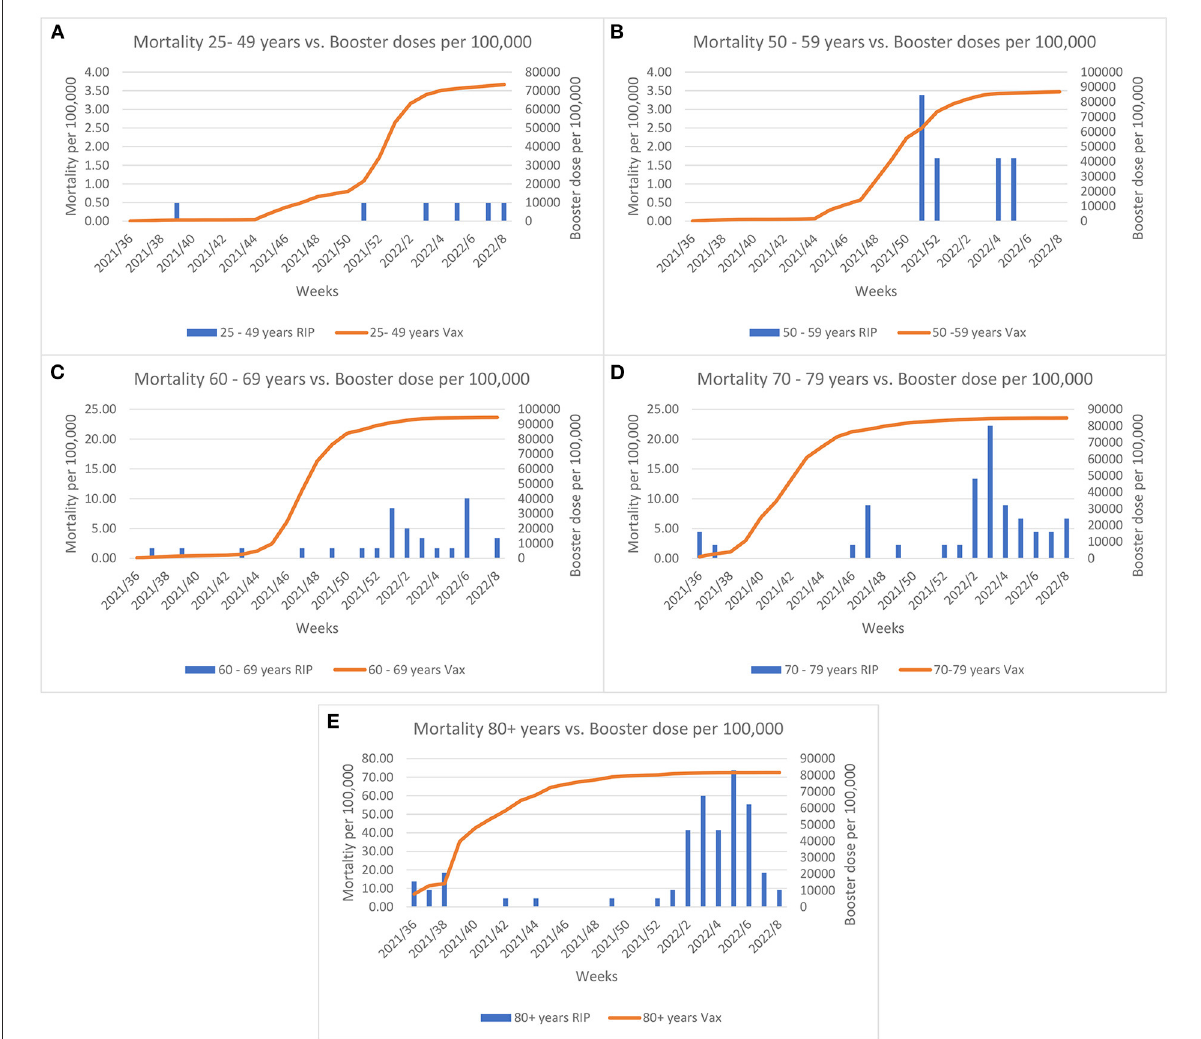
FIGURE3 Comparisons between morality rate and the booster dose coverage per 100,000 across age groups and weeks since initiation of the booster rollout. Left y-axis Graph (A,B) scale represents mortality up till 4 per 100,000; Graph (C,D) scale represents mortality up till 25 per 100,000 and Graph (E) represents mortality up till 80 per